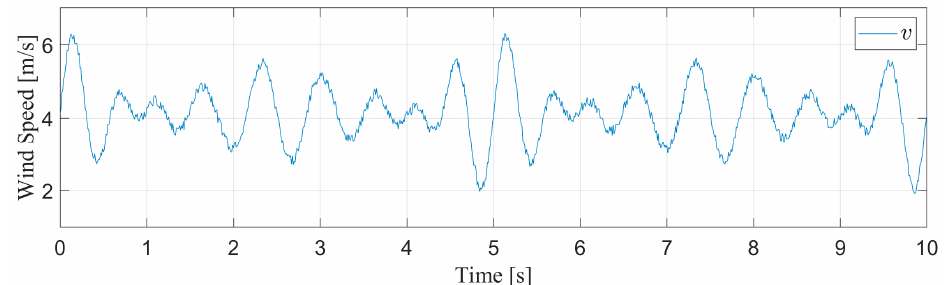
Figure 10. Turbulent wind speed used for controller comparison.